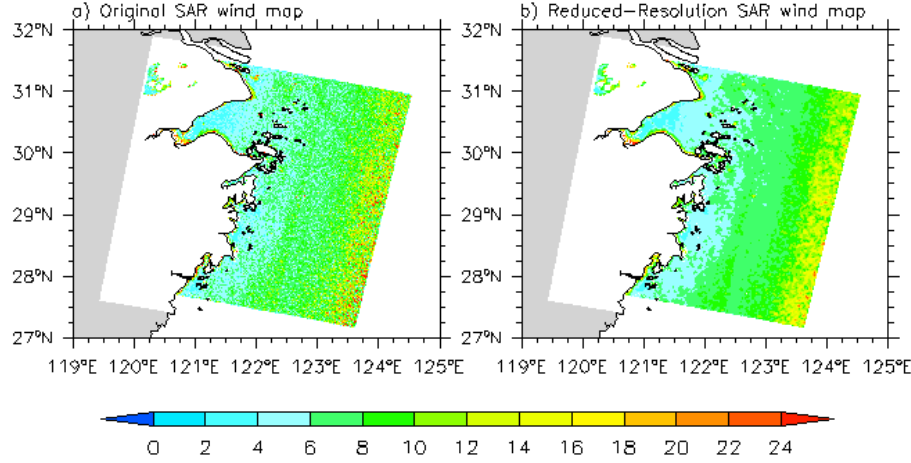
Figure 4. Analysis of SAR wind retrieval in 21 December 2009 over Hangzhou Bay, China: ( a ) the original wind retrieval; and ( b ) wind retrieval followed by spatial averaging.